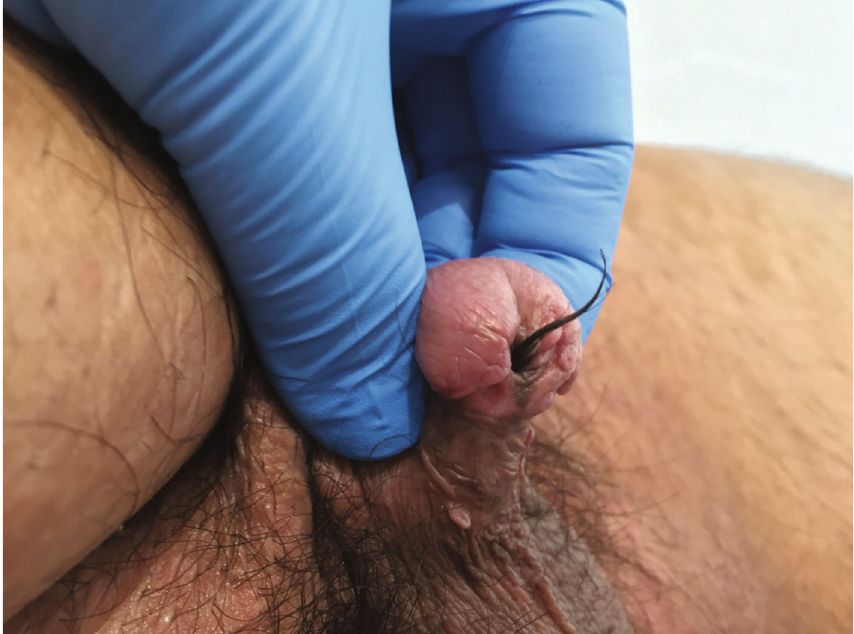
Figure 1: External appearance after dorsal penile island fl ap presenting a large amount of hair exiting the external meatus.